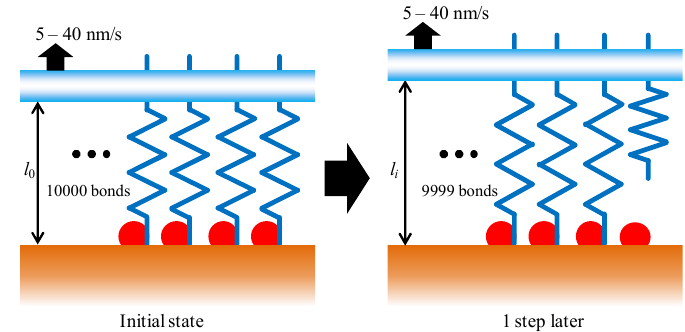
Fig. 4 Schematic illustration of the calculation model for the experiment by Kim et al. (8)